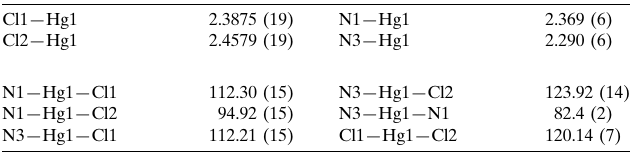
Selected geometric parameters (A˚ , (cid:2) ).